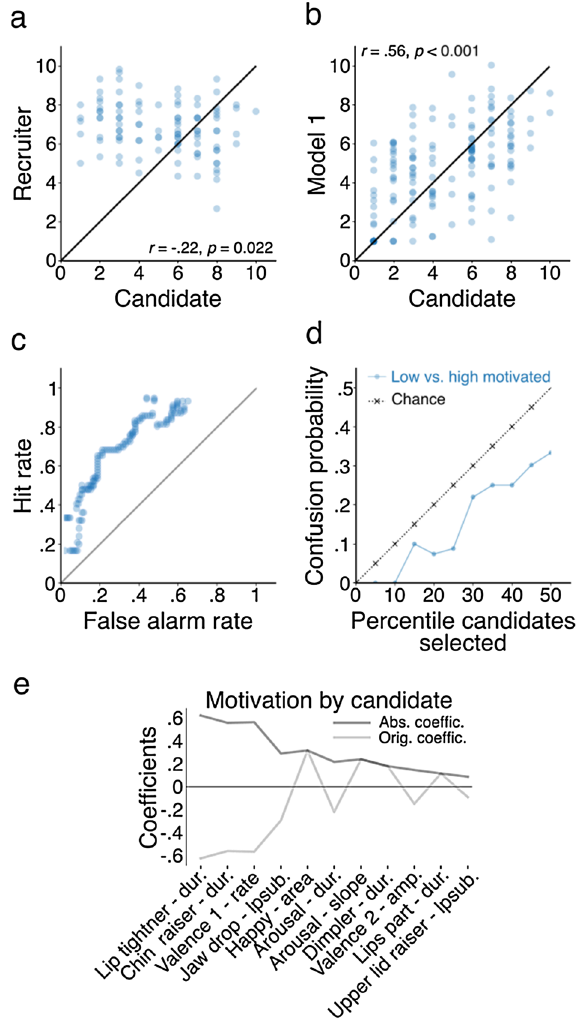
Figure 2. Predicting candidate evaluations. ( a ) Scatter plot correlation of motivation scores by candidates themselves (ground truth) versus recruiters. ( b ) Same as panel ( a ) but now for candidate versus CBMM model ratings. ( c ) Signal detection ROC curve with hit rate (sensitivity) as a function of false alarm rate (specificity). ( d ) Probability to confuse a CBMM-based high motivated candidate with a low motivated candidate. ( e ) Coefficients of features of the CBMM that determines scores of candidates themselves (dark grey line shows absolute values of the actual coefficients depicted in light